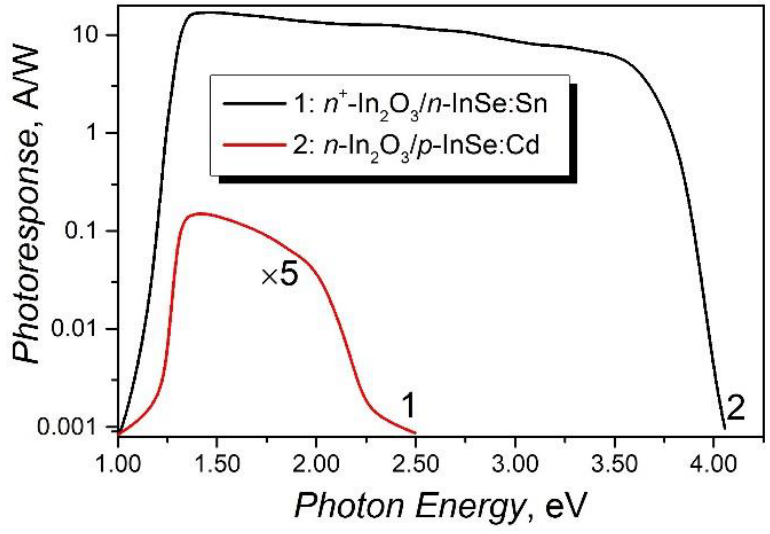
Figure 5. Photoresponse of n + –In 2 O 3 / n –InSe:Sn (curve 1) and n –In 2 O 3 / p –InSe:Cd (curve 2) hetero- junctions as a function of incident photon energy.